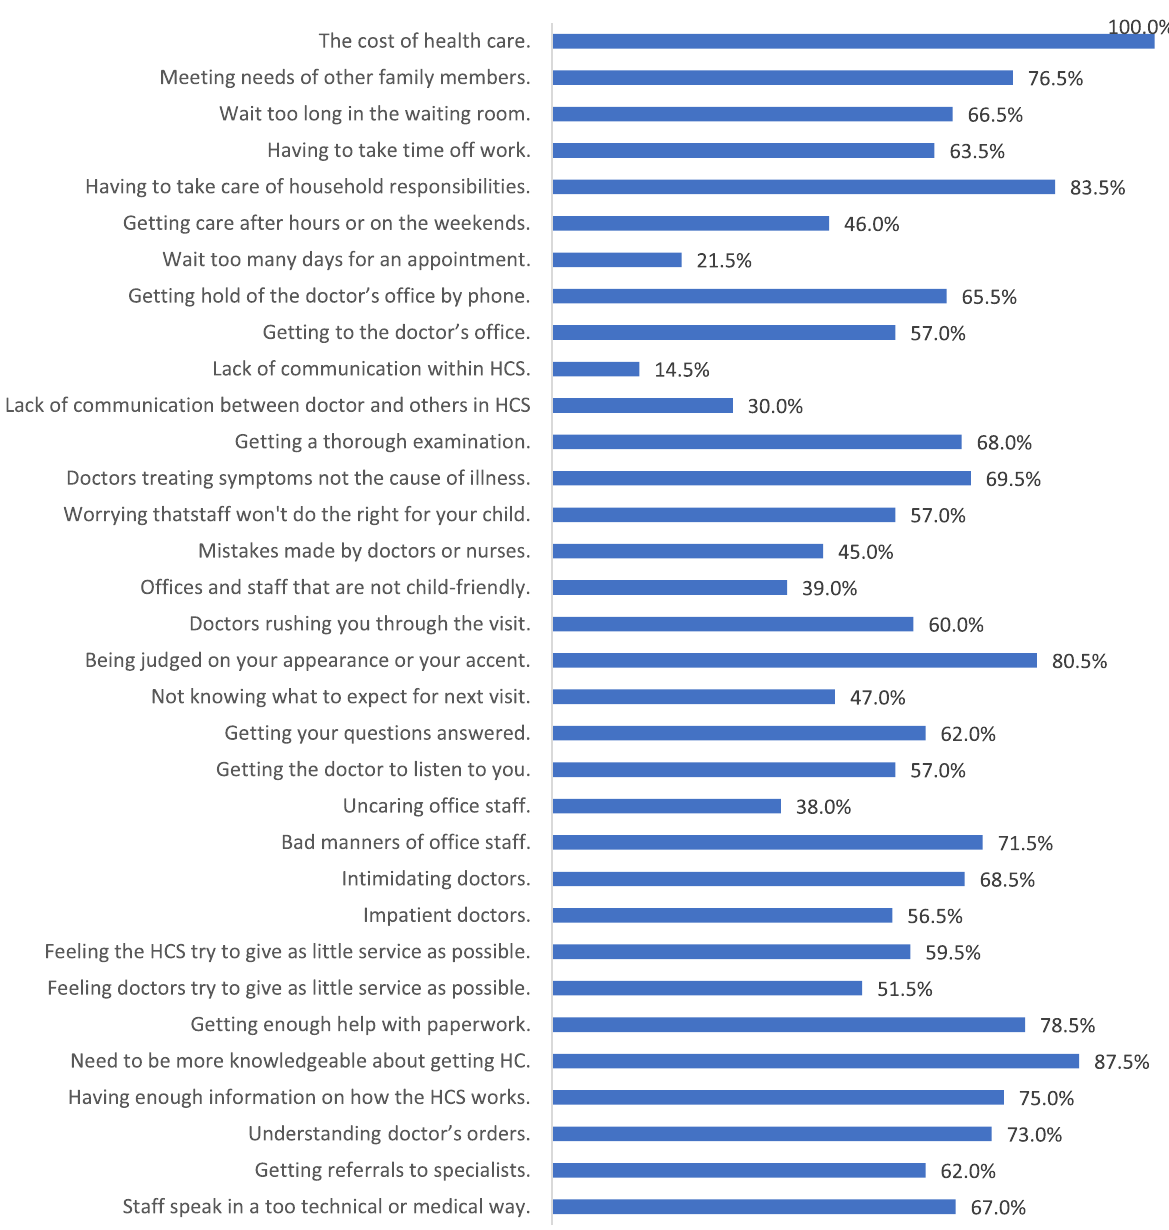
Fig. 3 Barriers expressed by parents in accessing quality healthcare for their children with cochlear implants within the healthcare system